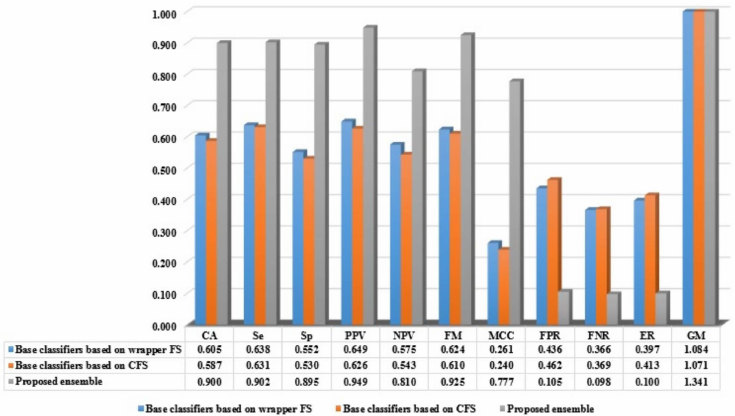
Figure 8. Comparison between the proposed framework and average results of base